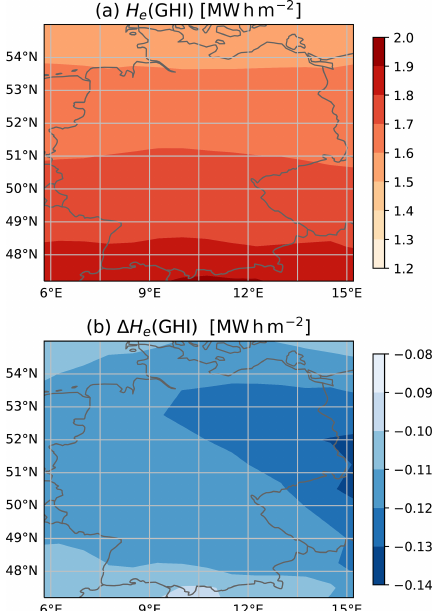
Figure 13. Annual radiant exposure ( H e = (cid:82) F GHI d t ) computed from GHI assuming cloud-free conditions (a) and reduction due to aerosols ( (cid:49)H e = H e − H e, pri , b ) at the surface over Germany in 2015. The calculation is conducted with the T–CARS setup.